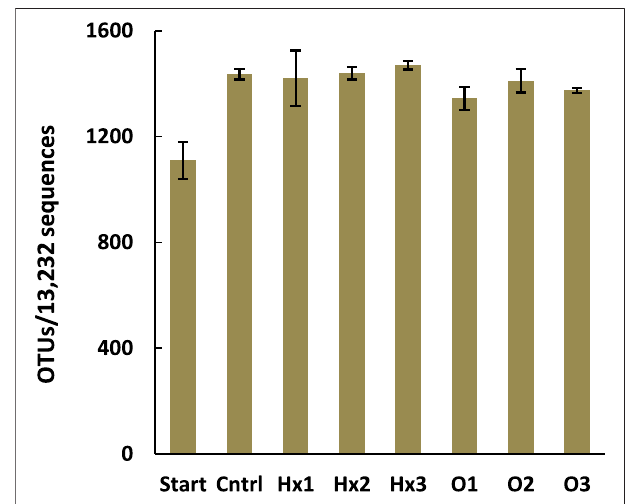
FIGURE 1 | The mean number of operational taxonomic units (OTUs) in the treatments after anequal amount of13,232sequences were analyzed per treatment. Error bars representthe SDs and n =4, except fortreatmentsCntrl and Hx1 n = 3 and for Start n =